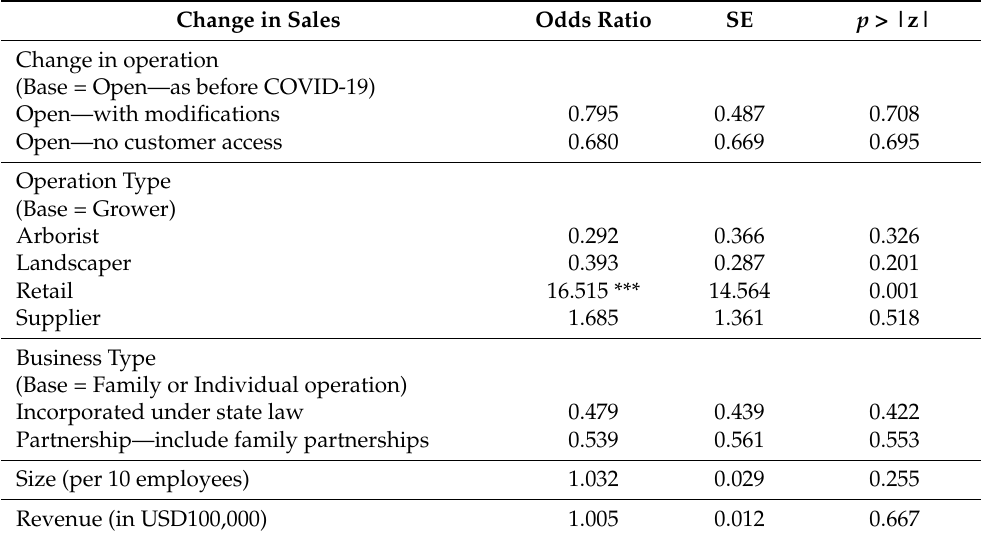
Table 2. Ordered logit model estimates for change in overall sales due to modified